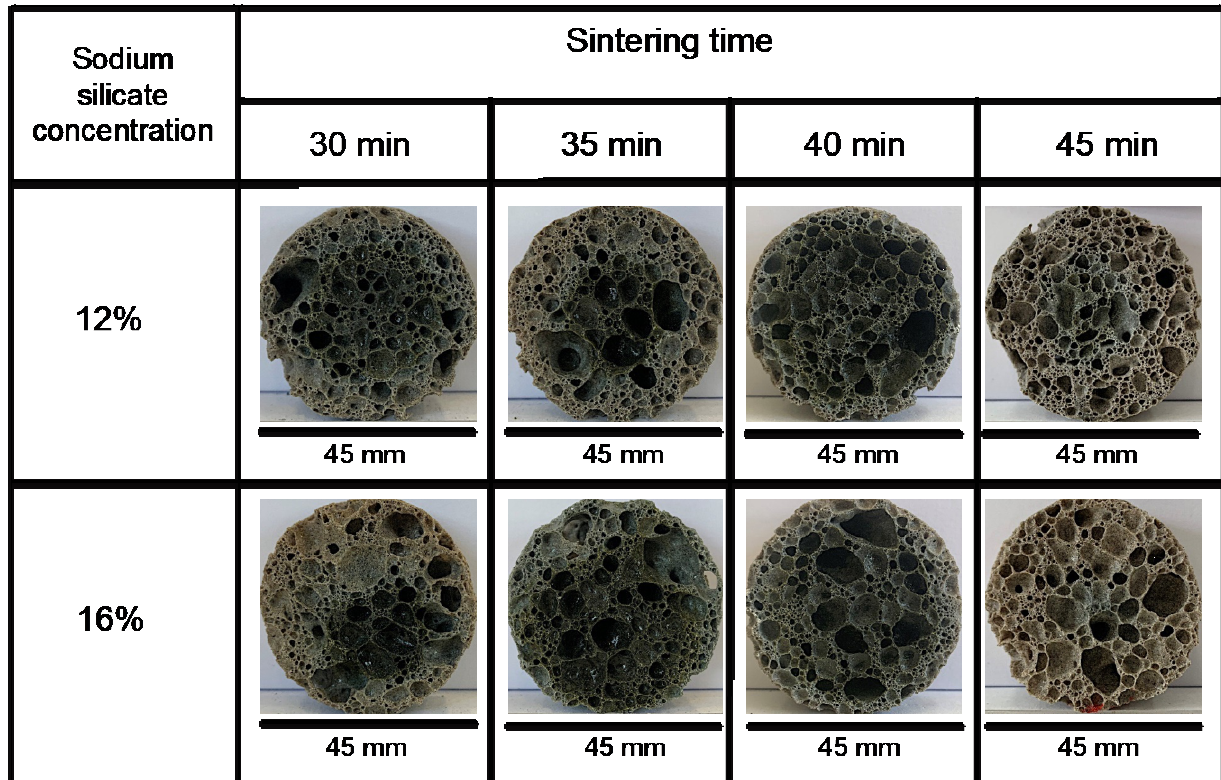
Figure 9. Effect of the sintering time on the development of the porosity of the ceramic foams sintered at 860 ° C.